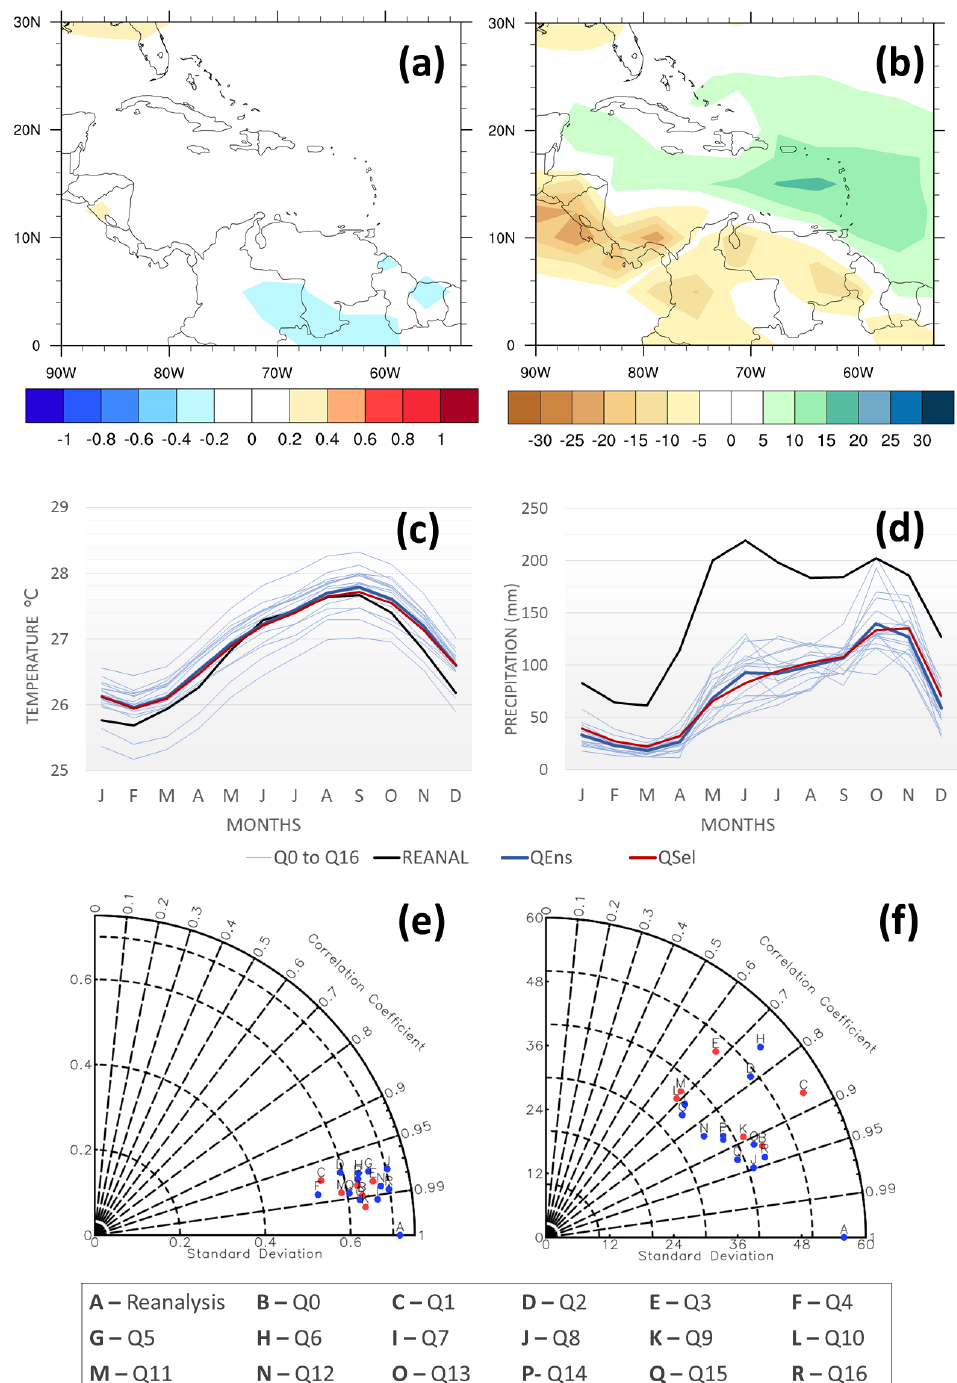
Figure 5. Top: Difference of mean of six selected ensemble members minus the mean of the full ensemble for ( a ) annual near-surface temperature ( ◦ C) and ( b ) precipitation (%). Middle: Graph showing monthly climatological means of ( c ) temperature and ( d ) precipitation. Bottom: Taylor diagrams of ( e ) temperature and ( f ) precipitation. For the middle and bottom rows, plots are for each of the 17-member QUMP simulations, ensemble means for the six-selected members (QSel), and the full ensemble (QEns) and